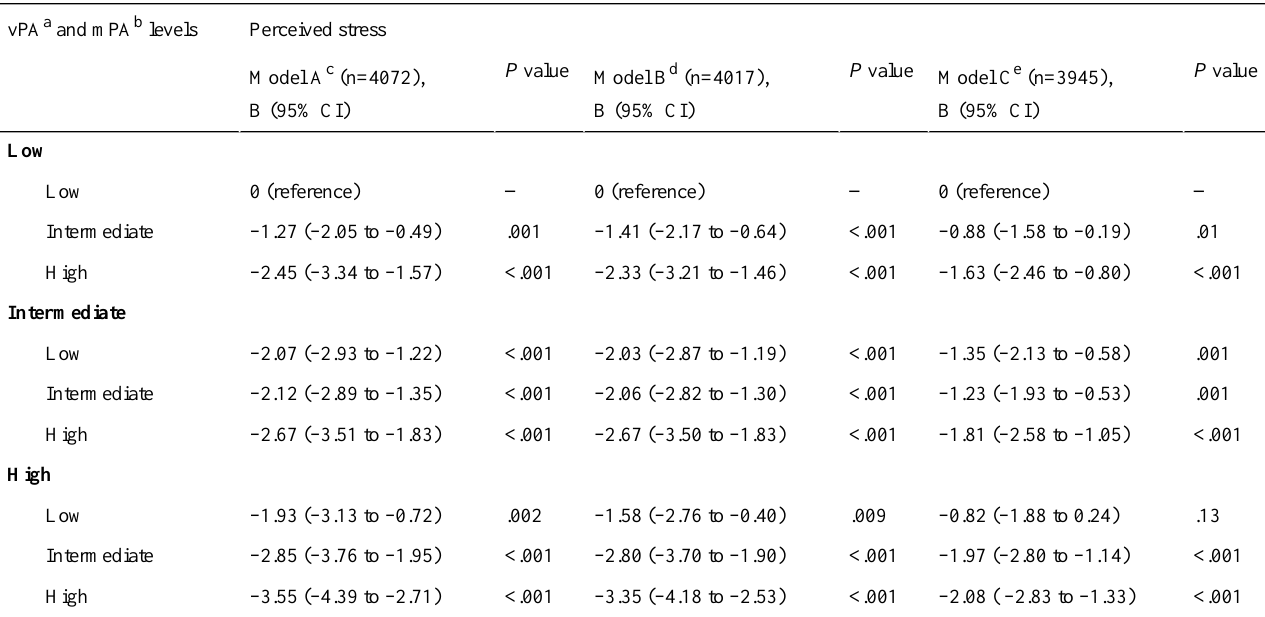
Table 4. Combined associations of vigorous and moderate physical activity on perceived